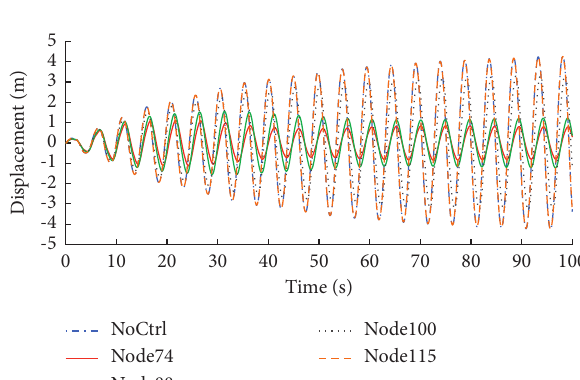
Figure 16: : Time history of the displacement of the SCR implemented with PTMD installed at different